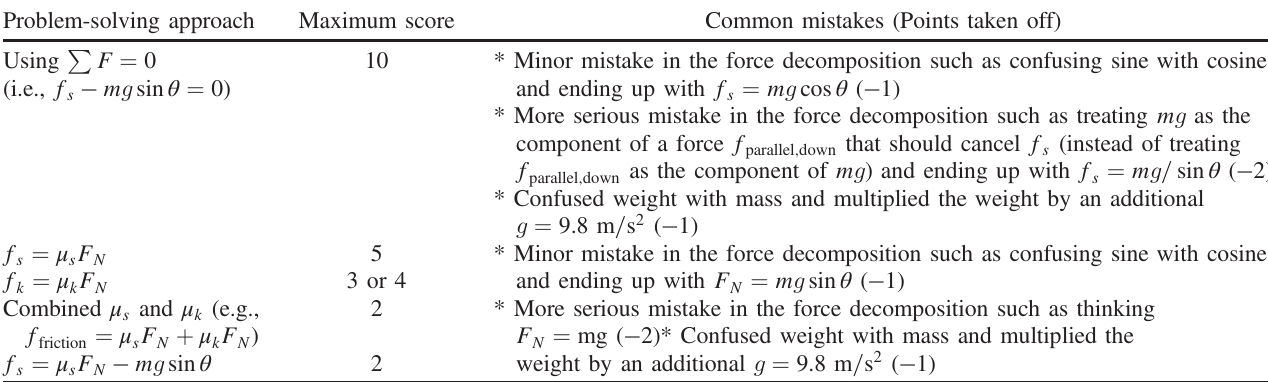
TABLE II. Summary of the rubric used to score students ’ performance in calculating the frictional force. Problem-solving